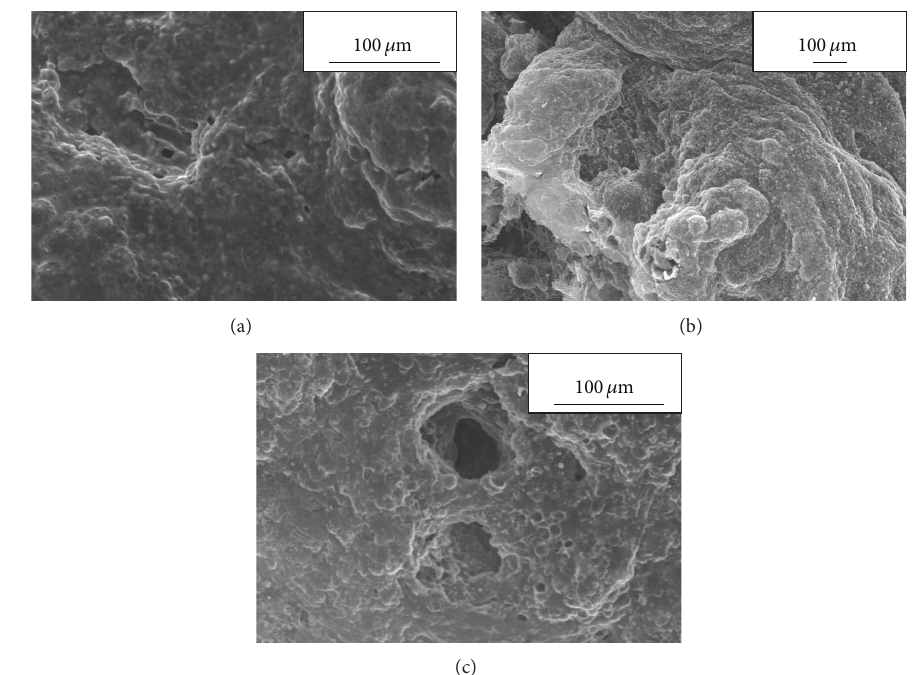
Figure 8: SEM photographs of outer char surface after LOI test: (a) PP0, (b) PP2, and (c)